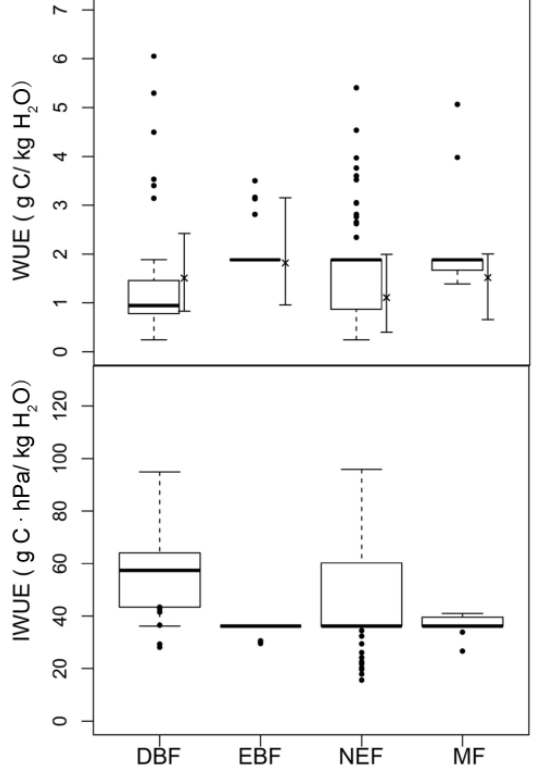
Fig. 6. Boxplot of water use efficiency (WUE) and inherent water use efficiency (IWUE) predicted by the Level 0 WUE model for four forest types: broad-leaved deciduous (DBF), broad-leaved ev- ergreen forest (EBF), needle-leaved evergreen forest (NEF), mixed forest (MF), compared with the results from Beer et al. (2009), in- dicated by scatter points, and from Zhu et al. (2011), indicated by the line segment (range) with a cross symbol (mean value).